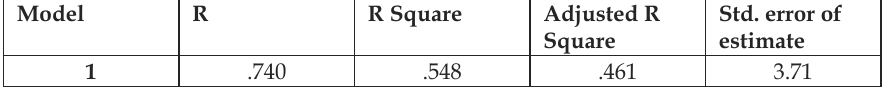
Tab. 7. Predictors of the tendency to leave the organization for the respondents above 35 years. Model summary.